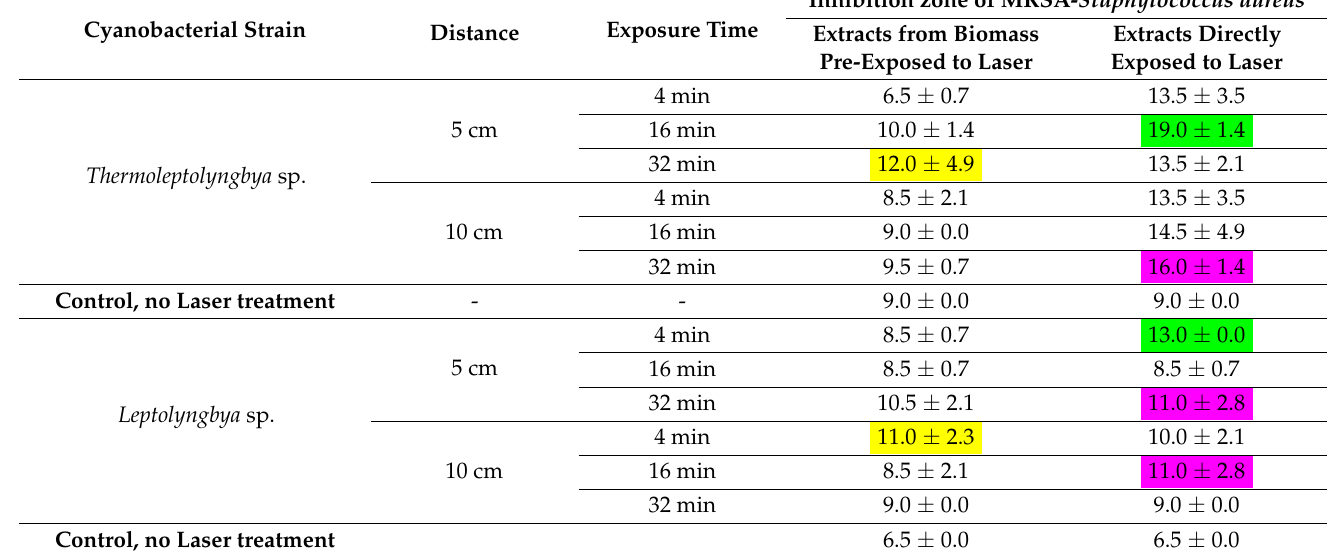
Table 2. Effect of interaction between distance and time intervals as functions of laser dose treatment on the antimicrobial effect of cyanobacterial extracts derived from cyanobacterial biomass pre-exposed to laser and cyanobacterial extracts directly exposed to laser against Methicillin-resistant Staphylococcus aureus . The highest statistically significant result is indicated in green ( p < 0.01); statistically significant results are indicated in pink ( p < 0.05); highest but statistically nonsignificant results are indicated in yellow.